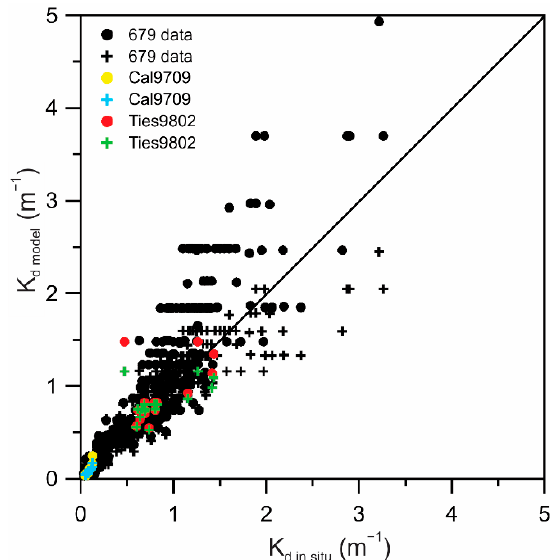
Figure 3. Comparison of K din situ vs. K d model calculated with the model of Lee et al. [18] (circles) and with model c (crosses), for the full database (black) and for two cruises with different optical conditions: Cal9709 (yellow and blue); Ties9802 (red and green).